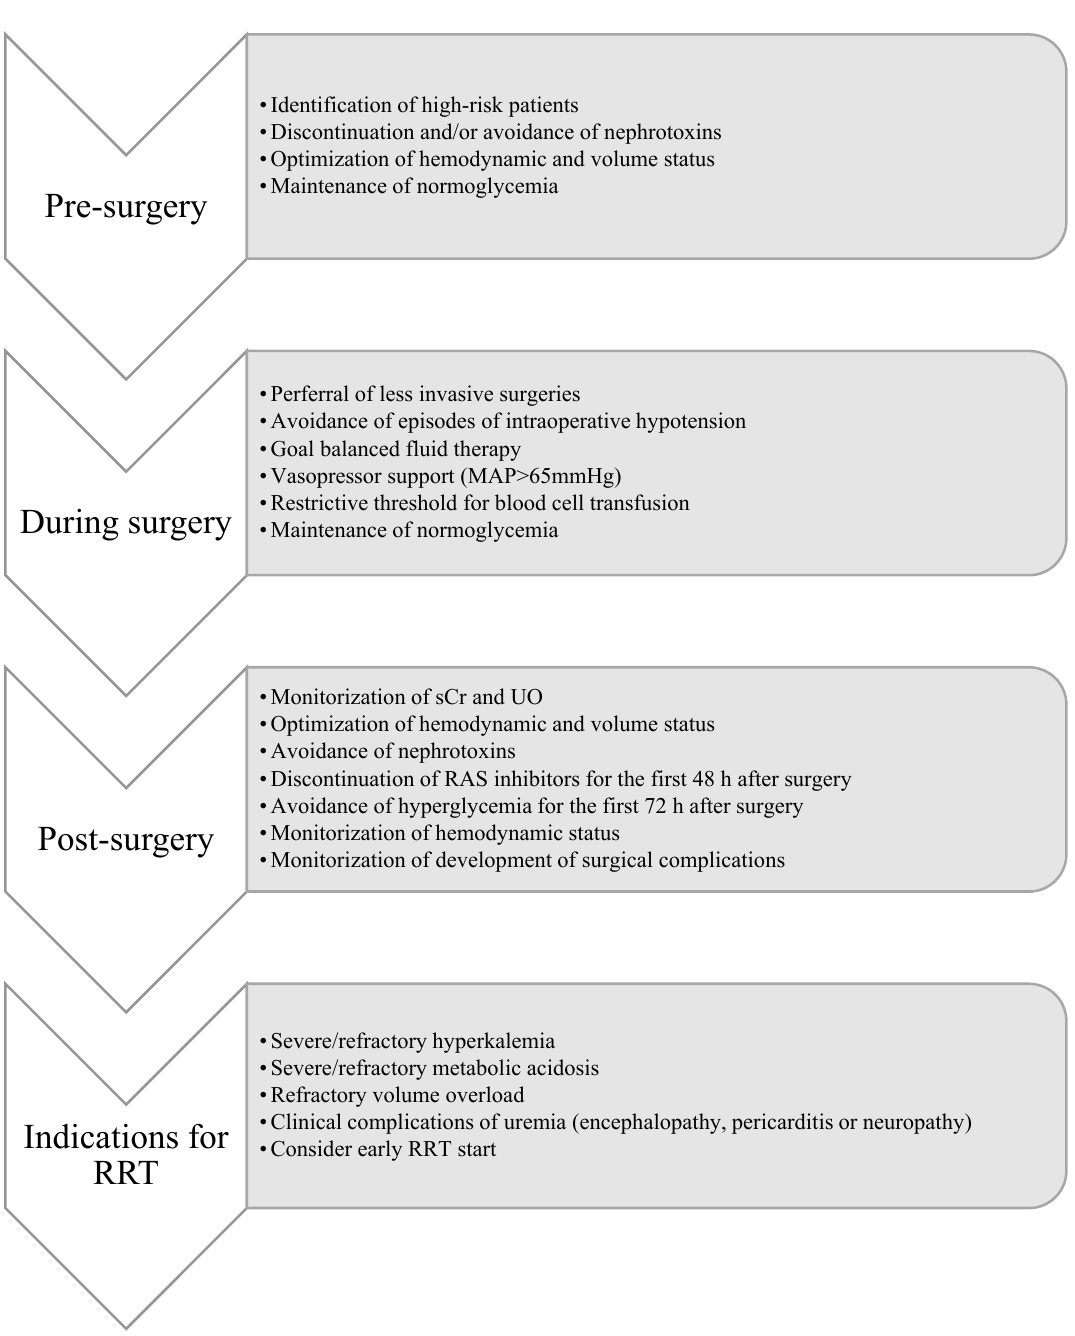
Figure 1. Management of AKI. MAP—mean arterial pressure; RRT—renal replacement therapy; SCr—serum creatinine; UO—urine output.